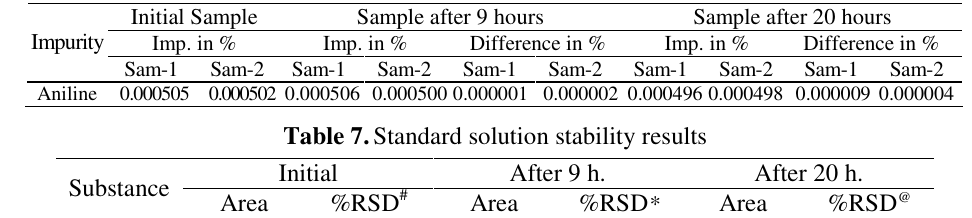
Table 6. Sample solution stability results